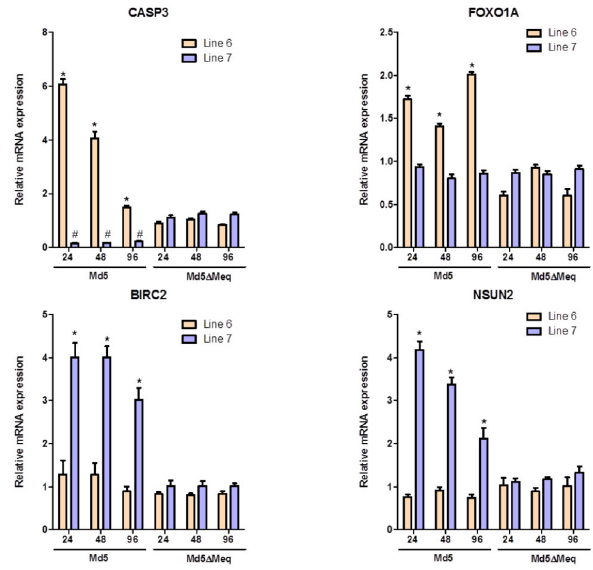
Figure 3. qPCR validation of microarray results. Validation by RT-qPCR of the microarray-based differentially expressed genes between line 6 and line 7 CEFs. Beta-actin was used as internal control. * P <0.05 compared to uninfected CEF as controls.